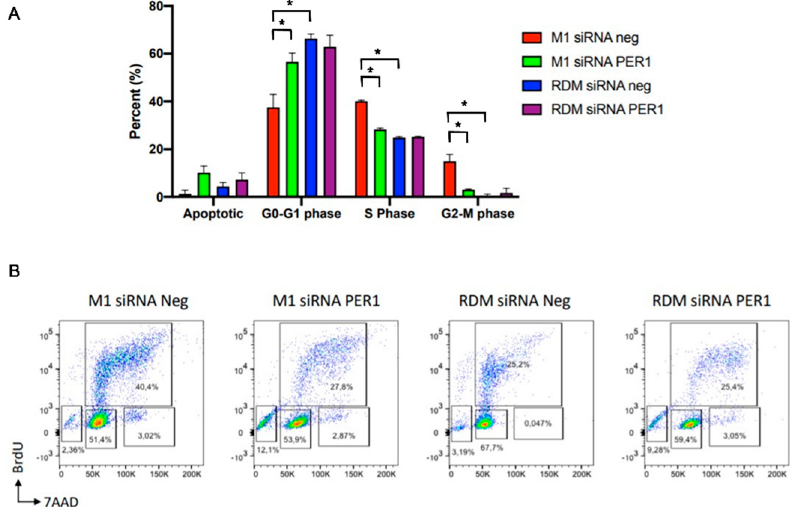
Figure 4. Cell cycle phase distribution analysis in HepG2 cells upon macroH2A1 knockdown and PER1 silencing. ( A ) The percentage of cells at G0/G1-, S-, and G2/M-phases is plotted. ( B ) Flow cytometry graphs showing the distribution of cycling cells by FACS analysis. See the Materials and Methods section for more details. RDM siRNA NEG = siRNA scramble-treated HepG2 cells; RDM siRNA PER1 = siRNA PER1-treated HepG2 cells; M1 siRNAneg = siRNA scramble-treated macroH2A1 knocked down HepG2 cells; M1 siRNA PER1 = siRNA PER1-treated macroH2A1 knocked down HepG2 cells; bars, standard error of mean (SEM); * p < 0.05; three biological replicates were each assayed in triplicate and results were expressed as mean ± standard error of mean (SEM). After 72 h of treatment with cisplatin at dosing scalars ranging from 0.1 to 100 µ